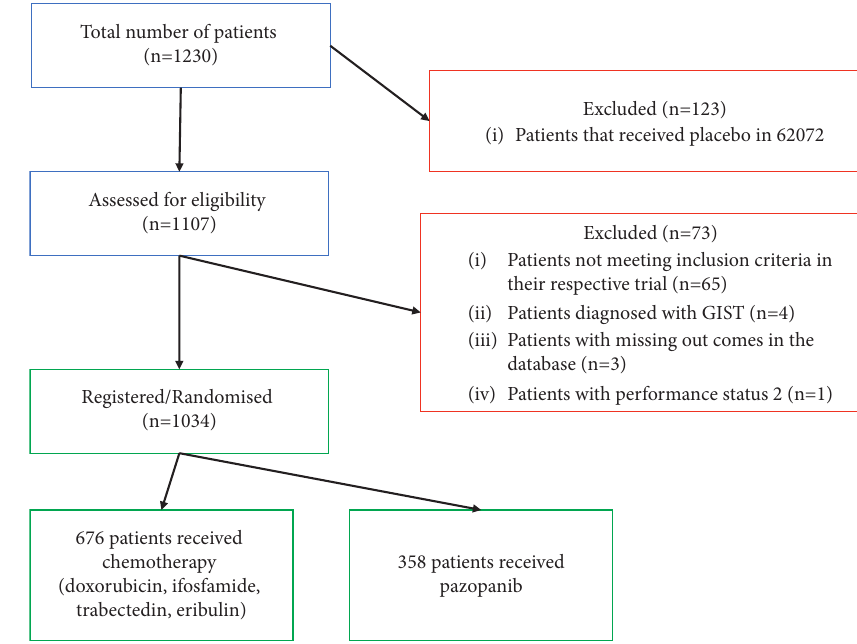
Figure 1: PRISMA flow diagram